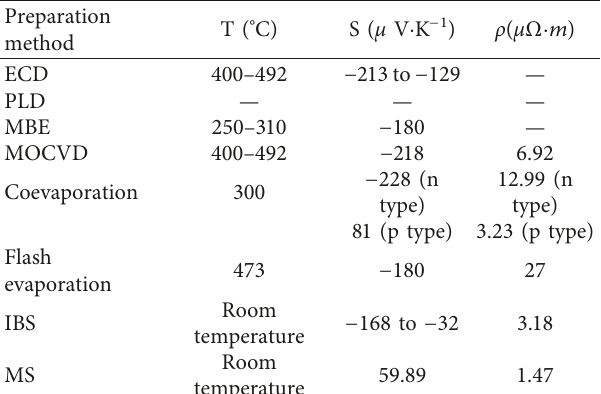
Table 3: The effect of doping contents on the thermoelectric properties of Bi 2 Te